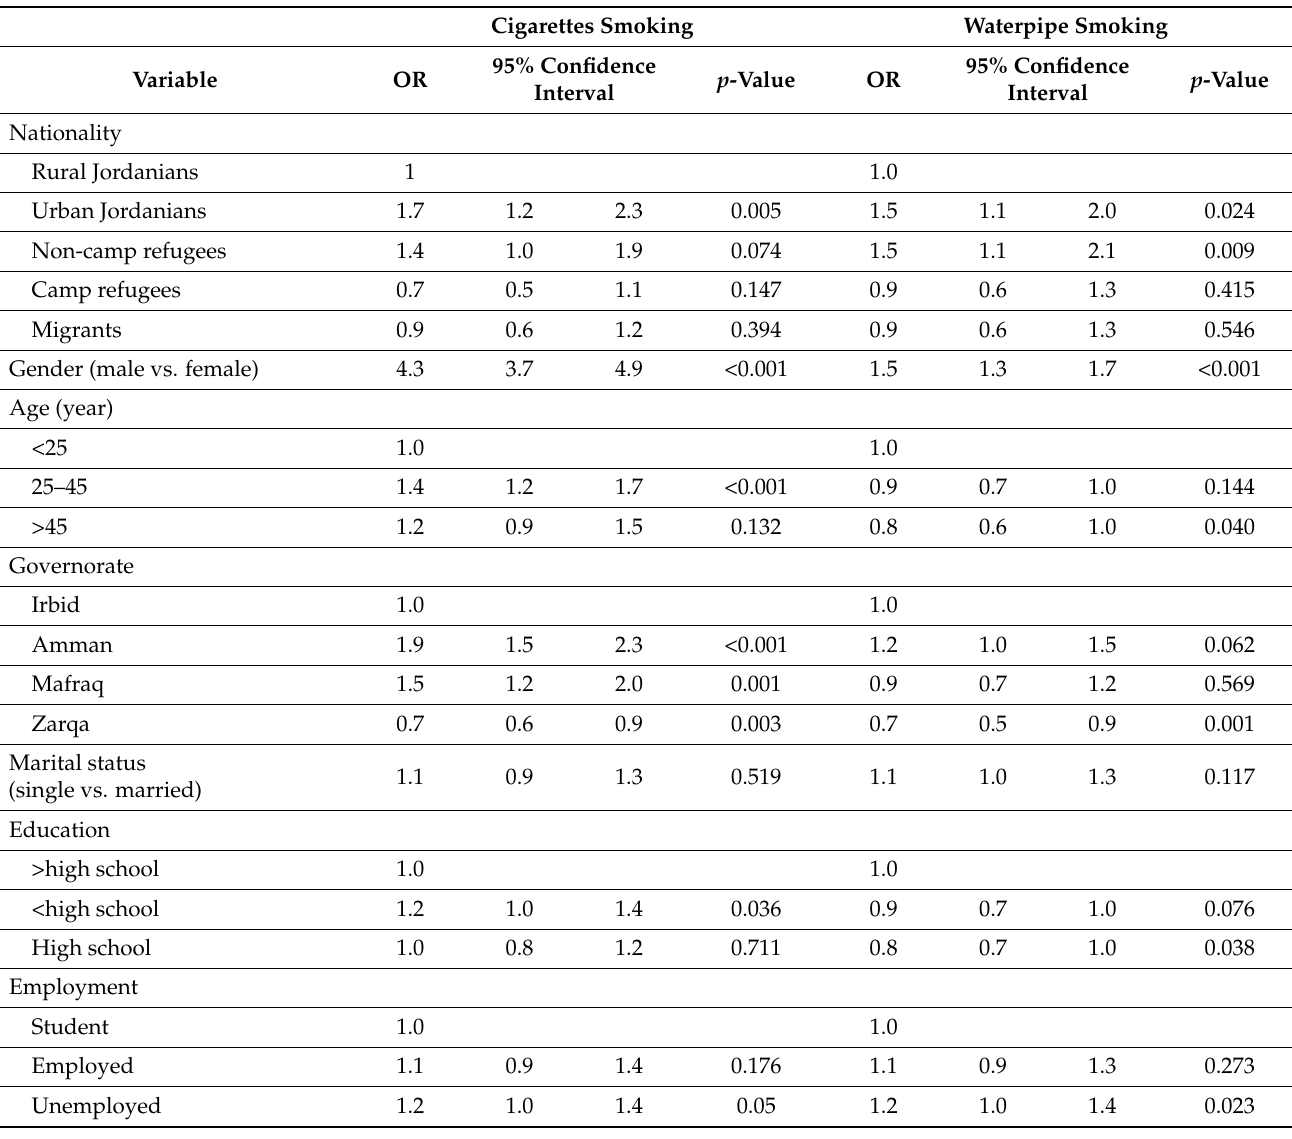
Table 3. Factors associated with cigarettes and waterpipe smoking among